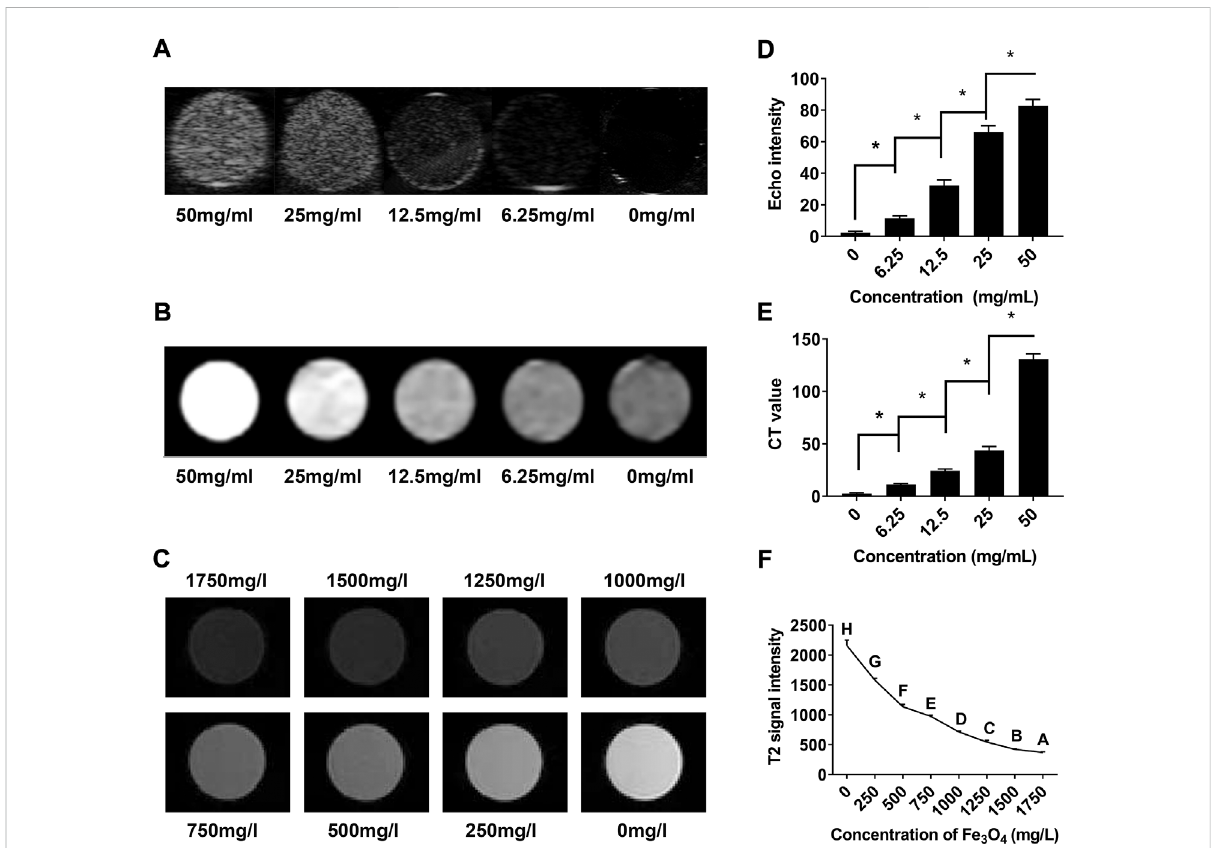
FIGURE 4 In vitro assessment of cRGD-PLGA-Fe 3 O 4 -PFOB NPs. (A) US images of cRGD-PLGA-Fe 3 O 4 -PFOB NPs at different concentrations. (B) CT images of cRGD-PLGA-Fe 3 O 4 -PFOB NPs at different concentrations. (C) T2-weighted MR images of cRGD-PLGA-Fe 3 O 4 -PFOB NPs at different Fe concentrationsinwater. (D) Echointensity of cRGD-PLGA-Fe 3 O 4 -PFOB NPsatdifferentconcentrations. (E) CTvaluesofcRGD-PLGA-Fe 3 O 4 -PFOB NPs at different concentrations. (F) T2 signal intensity of cRGD-PLGA-Fe 3 O 4 -PFOB NPs at different Fe concentrations in